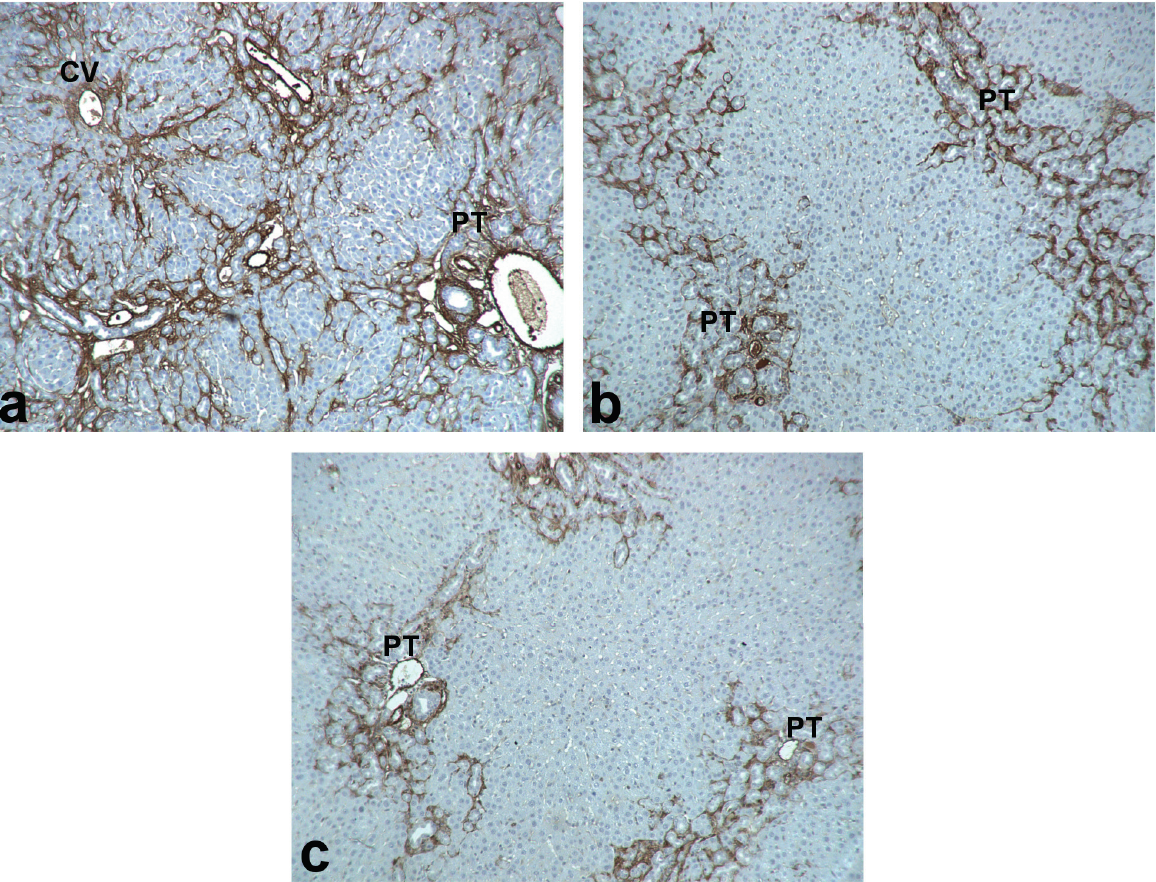
Figure 5 - Representative microphotographs of α-SMA immunoexpression in the experimental groups after 6 weeks of BDL. a ) Group Bdl; b ) Group Bdl+Am ; c ) Group Bdl+ Am . Portal tract (PT); Central Vein (CV). Magnifi cation of 0 1